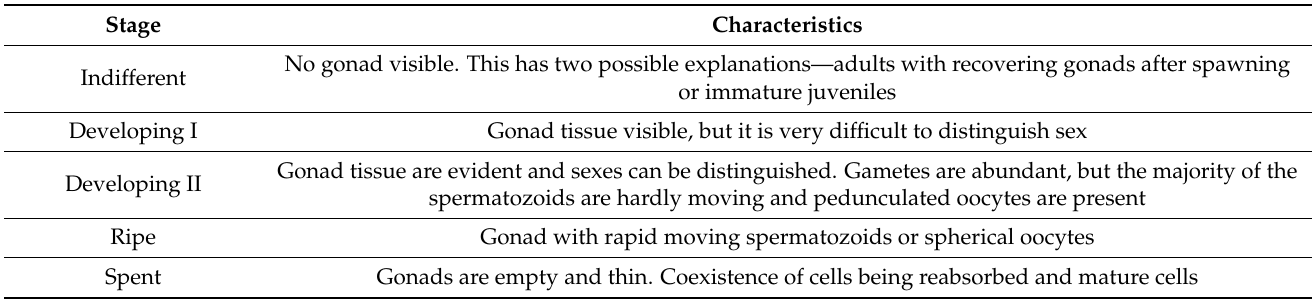
Table 1. Stages of gonadal development in oyster.